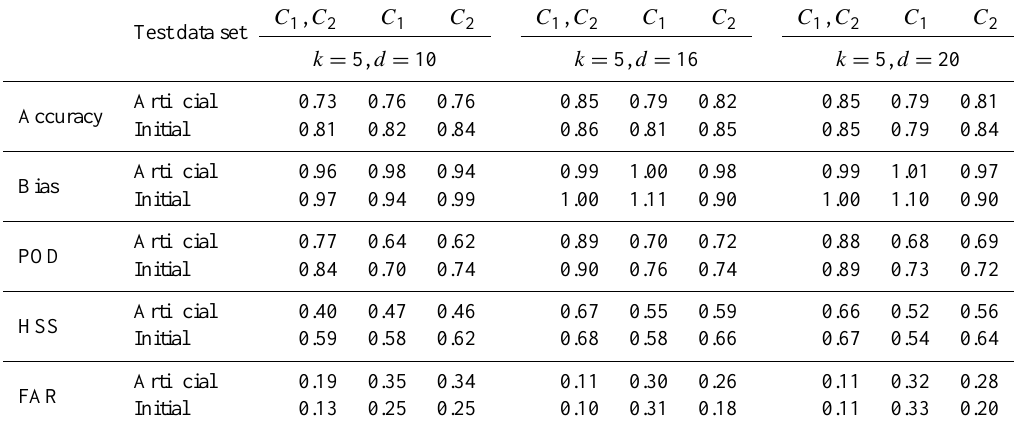
Table 3. Statistical scores related to the RainCEIV rain rate results obtained classifying the initial and artificial test data set for k = 5. The statistical scores are shown for all the rainy classes ( C 1 , C 2 ) , light to moderate rain ( C 1 ) , and heavy to very heavy rain ( C 2 )